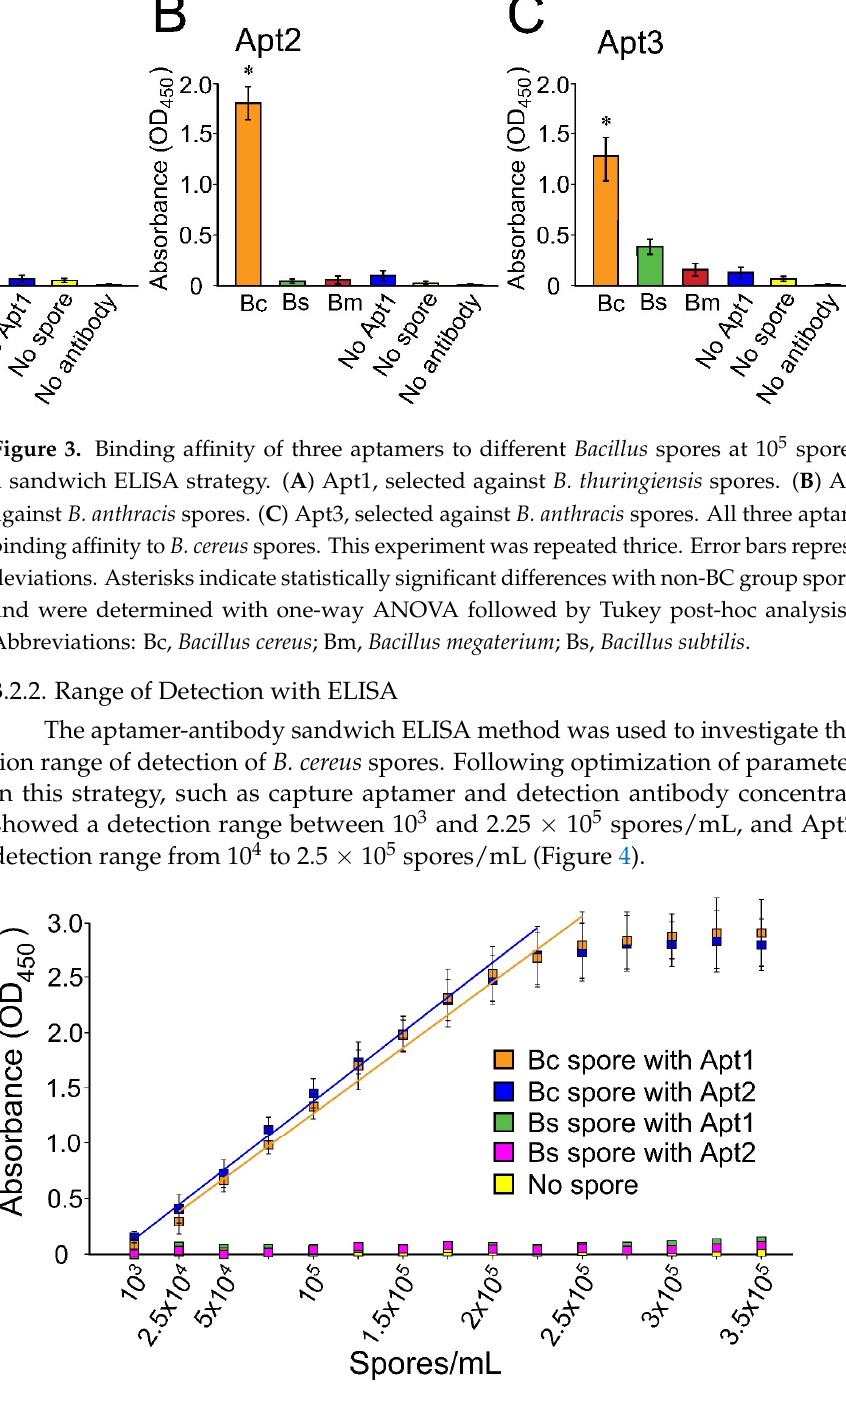
Figure 5. Range of detection of Apt3 using ELISA. This experiment was repeated thrice. Error bars represent standard deviations. A trend line is shown to highlight the linear range of detection. Ab- breviations: Bc, Bacillus cereus ; Bs, Bacillus subtilis .